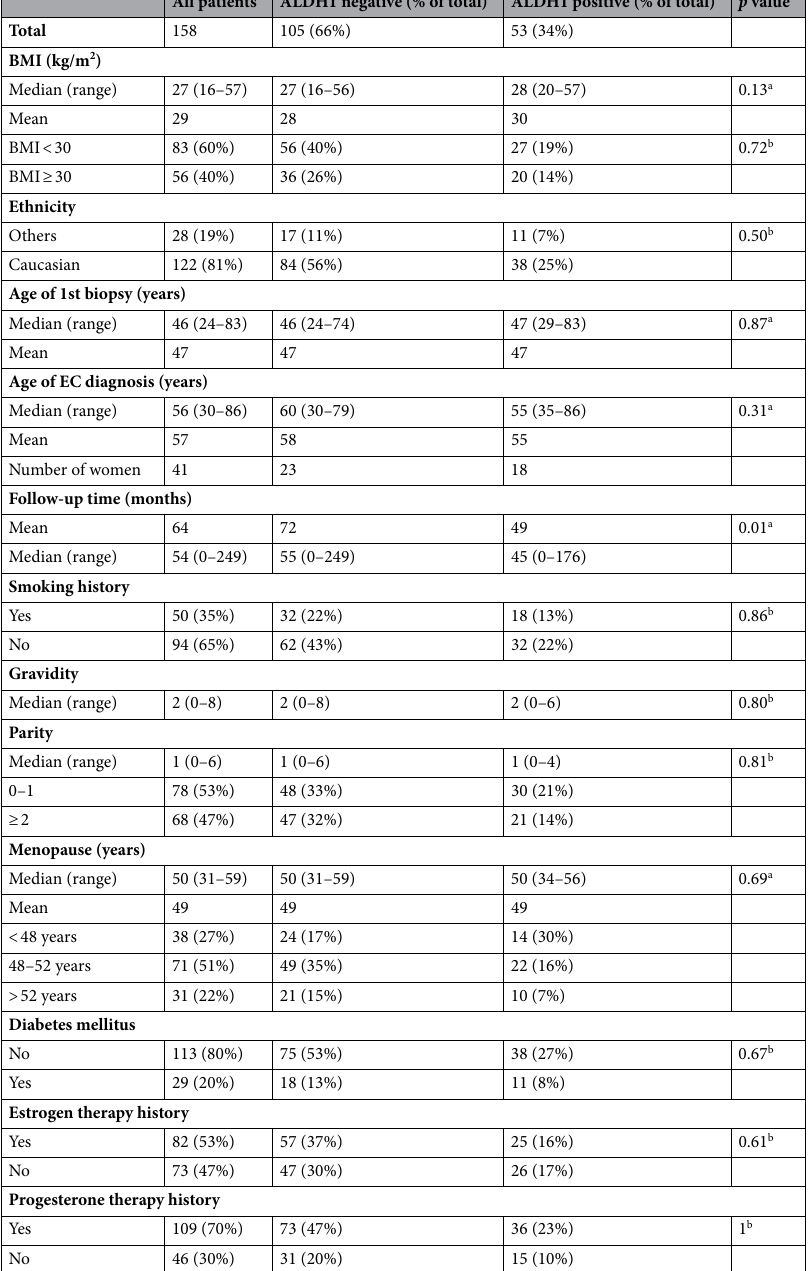
Table 1. Clinical variables and patient groups stratified based on cytoplasmic ALDH1 expression. a Mann– Whitney. b Fisher’s